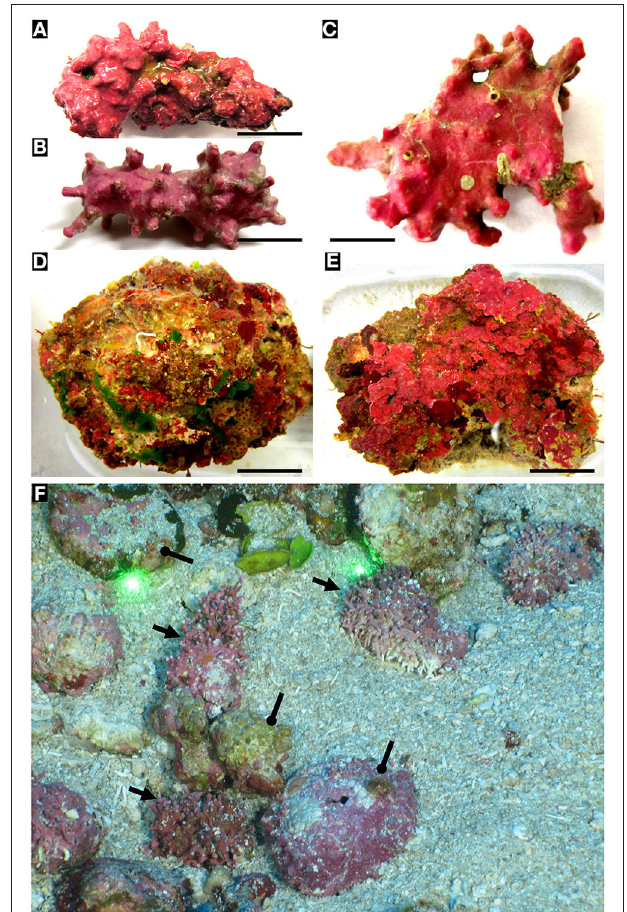
FIGURE 4 | Biogenic and autogenic rhodoliths. (A) biogenic rhodoliths. (A,B) Lithothamnion spp. (Hapalidiales). Scale bars: 0.8cm; 0.5cm. (C) Sporolithon sinumexicanum (Sporolithales) collected from the central cavity of a sponge. Scale bar: 0.5cm. (D,E) Examples of NWGMx autogenic rhodoliths. Scale bars: 1.5cm; 2cm. (F) Mohawk ROV photo taken on 24 Sept. 2018 of biogenic (arrows) and autogenic rhodoliths (circle pointers) in East Flower Garden Bank (FGBNMS), 27 ◦ 55’ 21.9612“N, 93 ◦ 35’31.6674”W, 50.9 depth (Dive 702_0007_131247). Space between spot lasers =